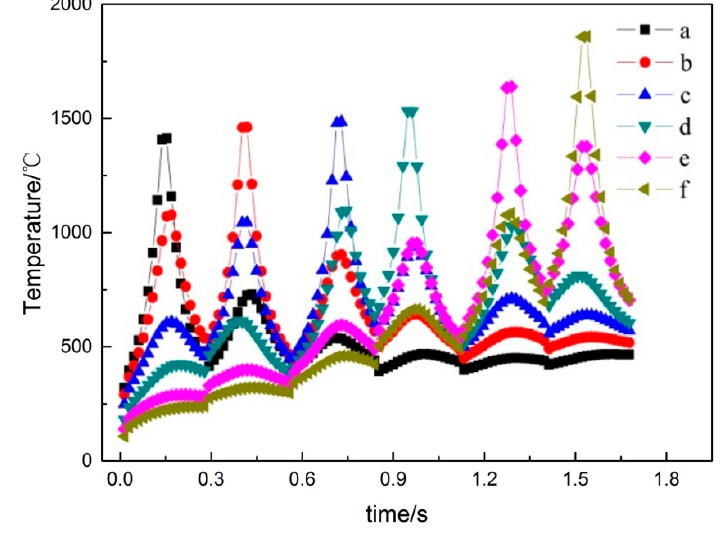
Figure 3. The temperature curves of points a, b, c, d, e, and f.